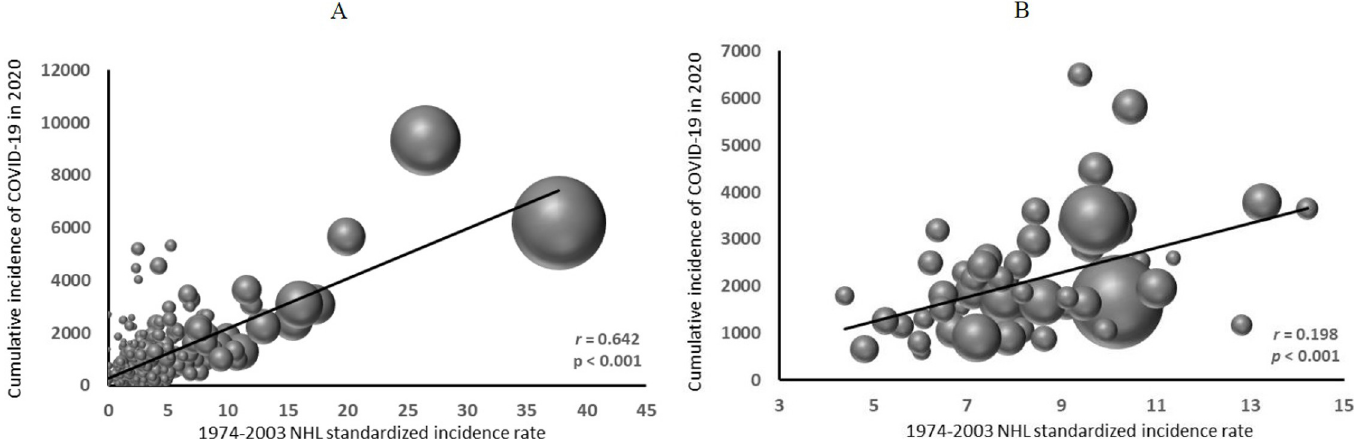
Fig 1. Bubble graph of 2020 cumulative incidence of COVID-19 in relation to 1974–2003 incidence of non-Hodgkin’s lymphoma in Sardinia, Italy. A. all communes (N = 356), weighed (weigh = resident population); B. 61 residential units, including 25 communes with 10000 residents or more and 36 sub-regional areas incorporating the remaining 331 communes. Each commune is represented by a bubble of diameter proportional to its population size relative to the total regional population.